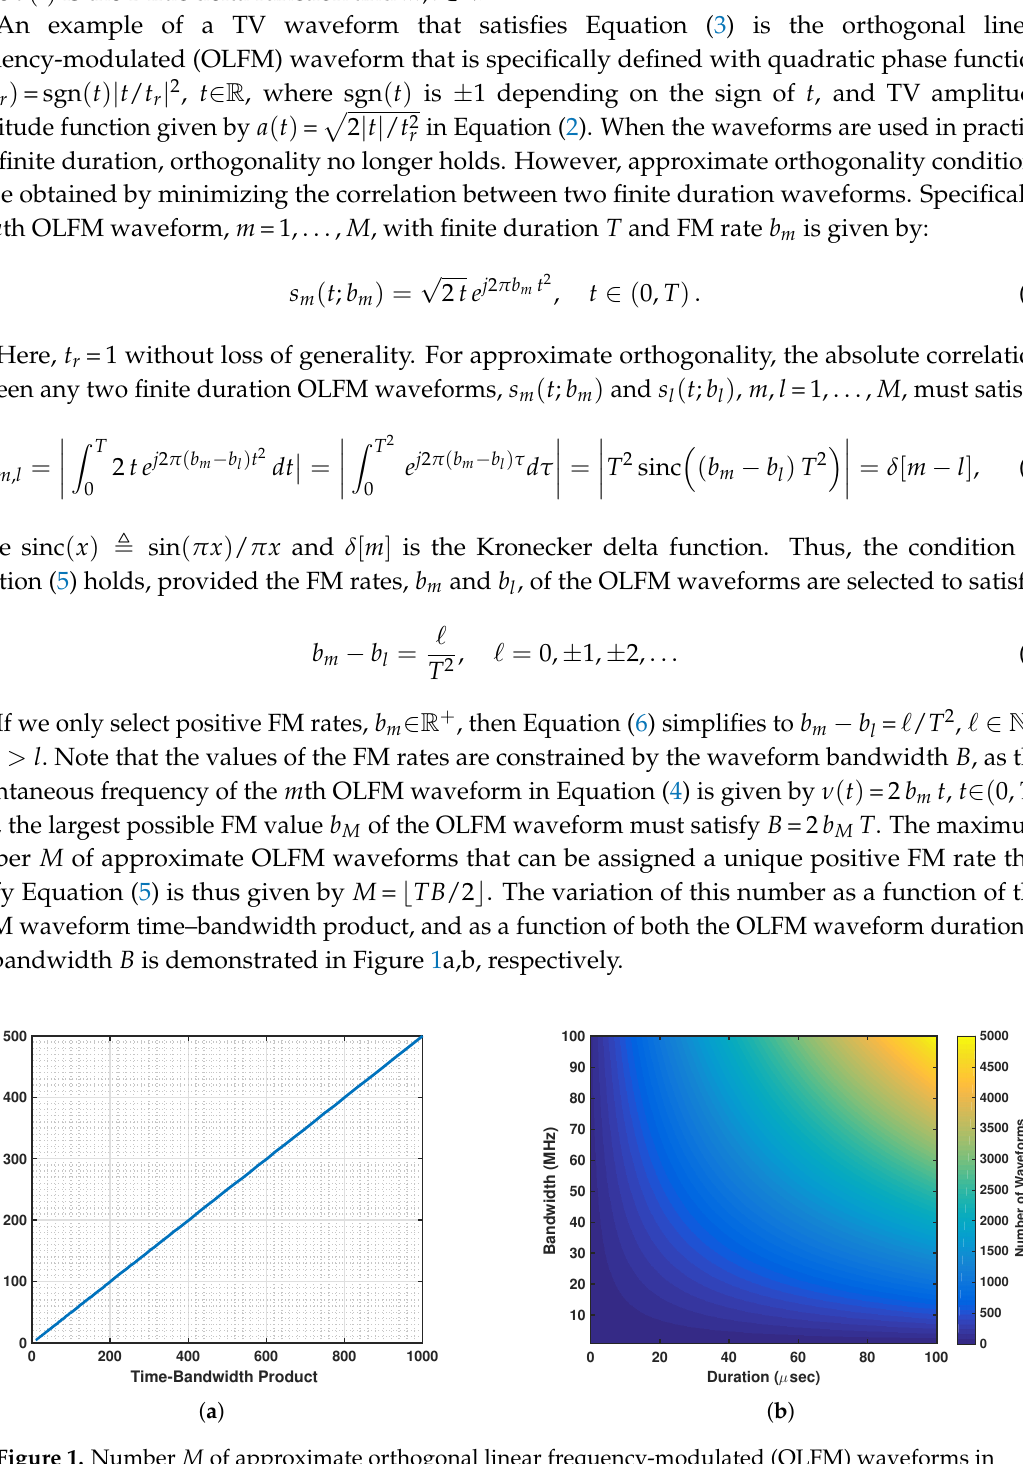
Figure 1. Number M of approximate orthogonal linear frequency-modulated (OLFM) waveforms in Equation (4) for varying ( a ) time–bandwidth product TB ; and ( b ) both duration T and bandwidth B